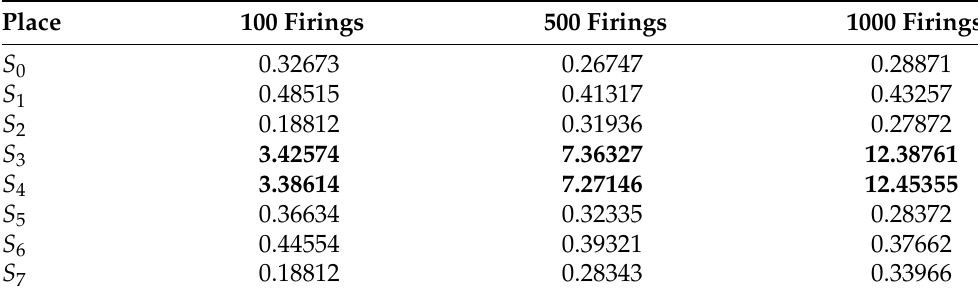
Table 2. The average number of tokens after simulation in Petri net of ACC (The Bold indicates incremental